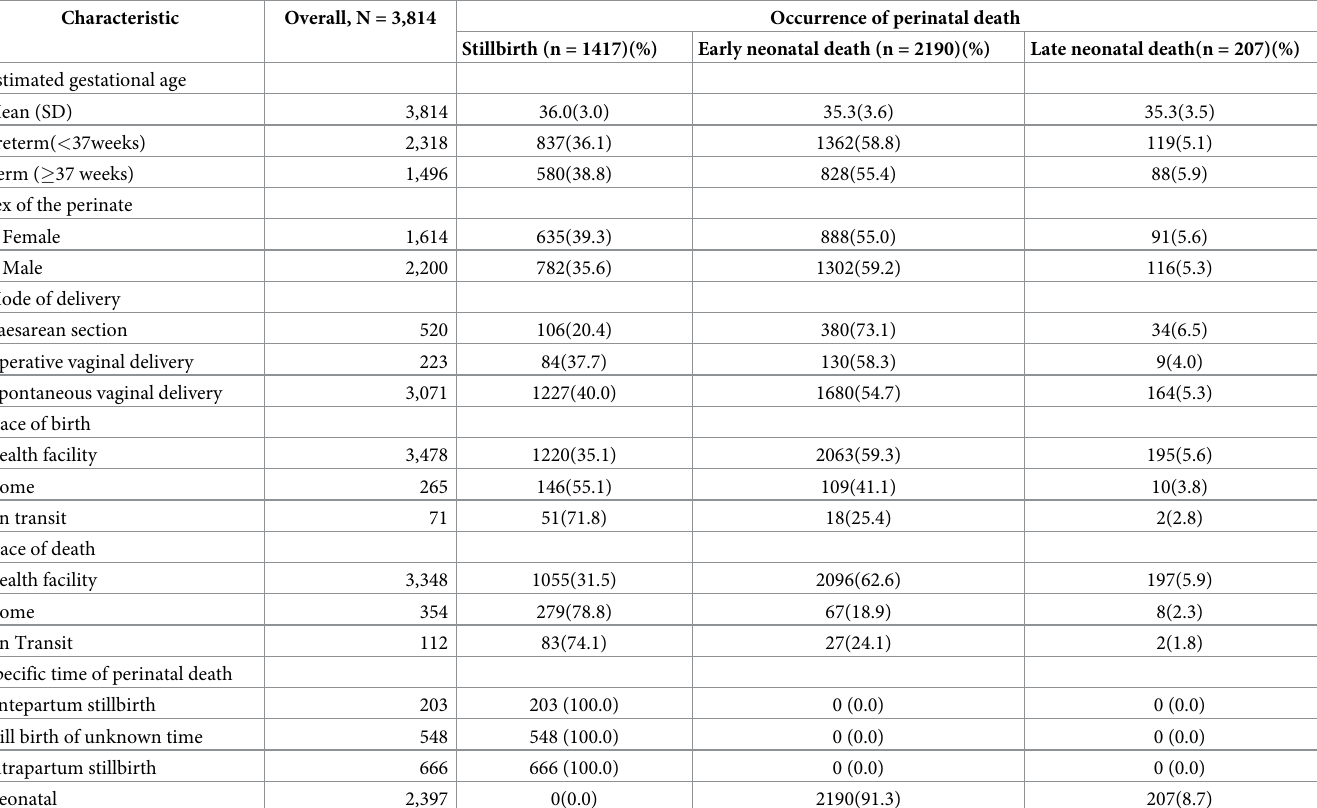
Table 6. Selected characteristics of the deceased perinate by the timing of death in Ethiopia,2021.